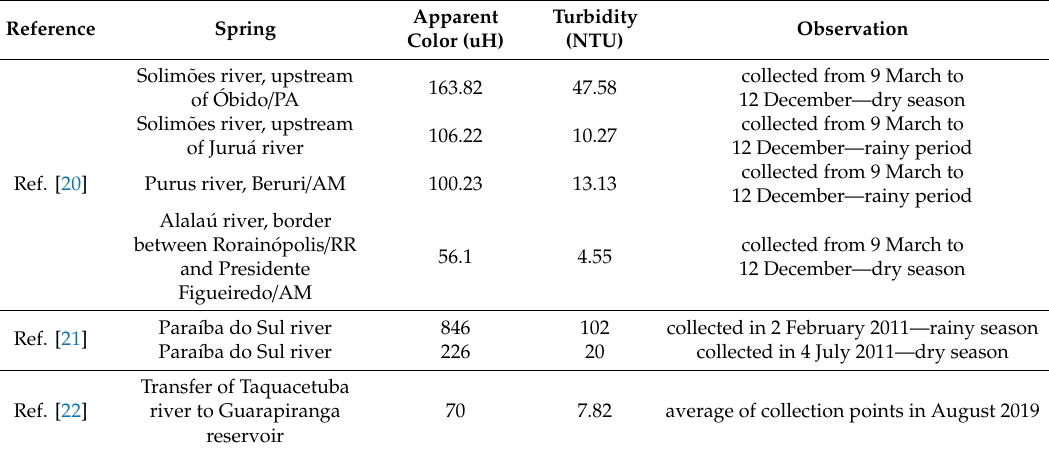
Table 1. Brazilian springs with high levels of apparent color turbidity